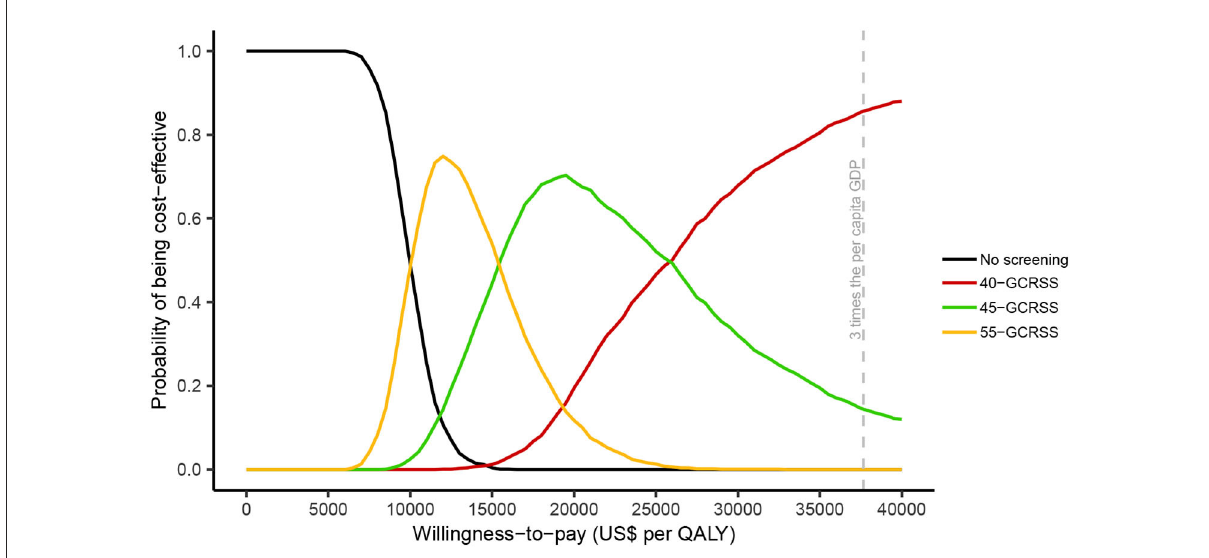
FIGURE5 Cost-effectiveness acceptability curves. QALY, quality-adjusted life year; GDP, gross domestic product; GCRSS, gastric cancer risk score